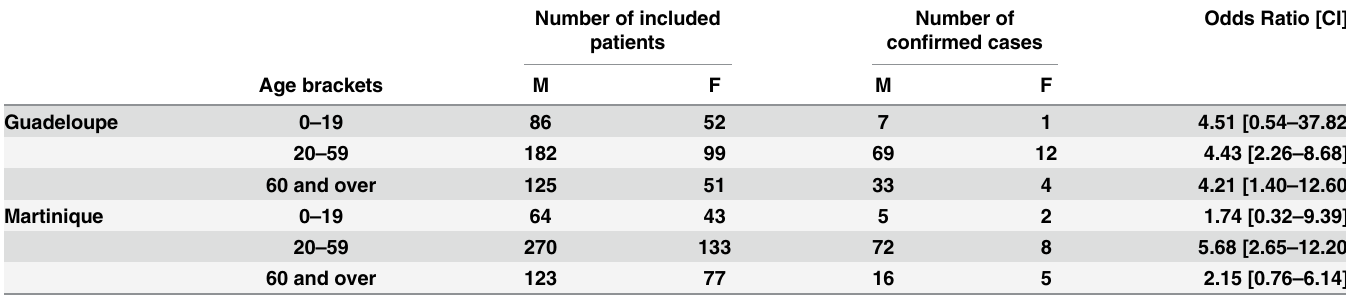
Table 3. Number of included and confirmed patients, according to gender and age, gender odds ratio and confidence intervals, Guadeloupe and Martinique, 2011. Number of included